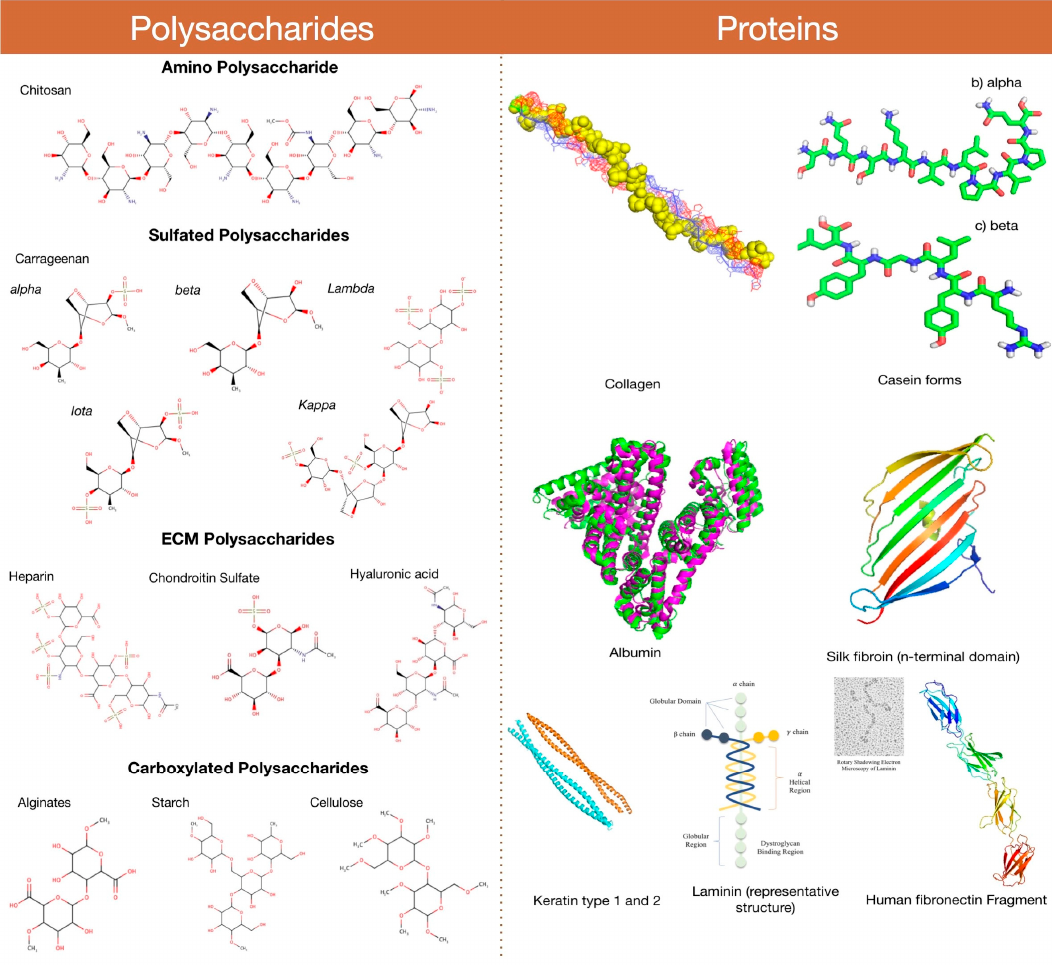
Figure 1. Structures of polysaccharides and proteins that are extensively explored for their uses in nanotechnology and regenerative medicine. Proteins show structural homology between human and bovine serum albumin structures (pink: human serum albumin and green: bovine serum albumin with RMSD score of 2.3). The figure also shows representative structure and electron microscope image of Laminin [8]. It also shows the human fibronectin fragment type III. Reproduced with permission from [8].